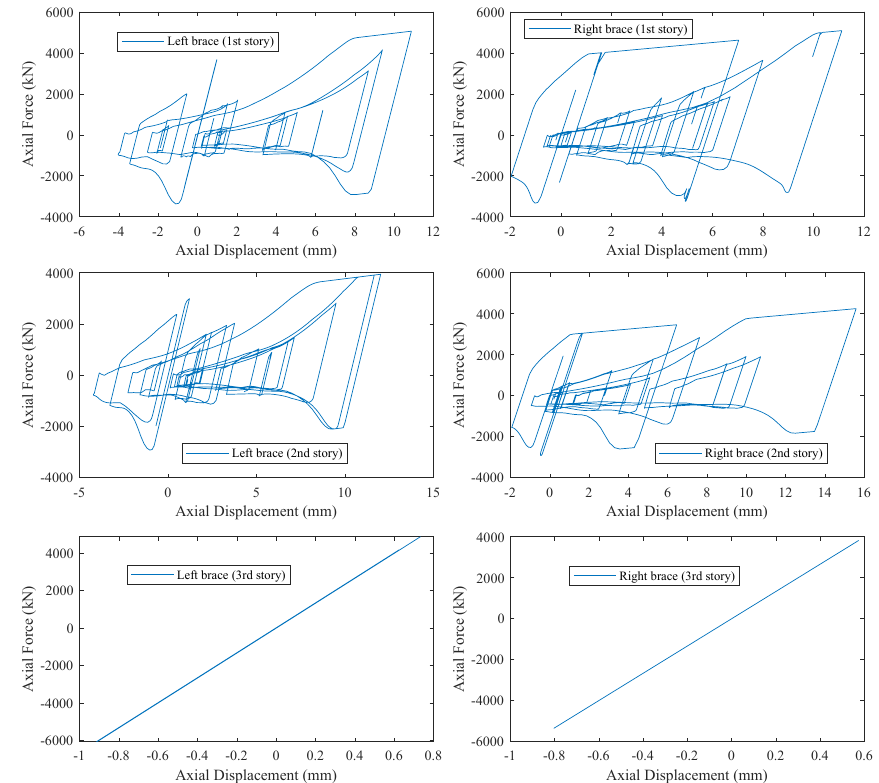
Figure 8. Axial force-axial displacement for the braces in the chevron-braced frame.